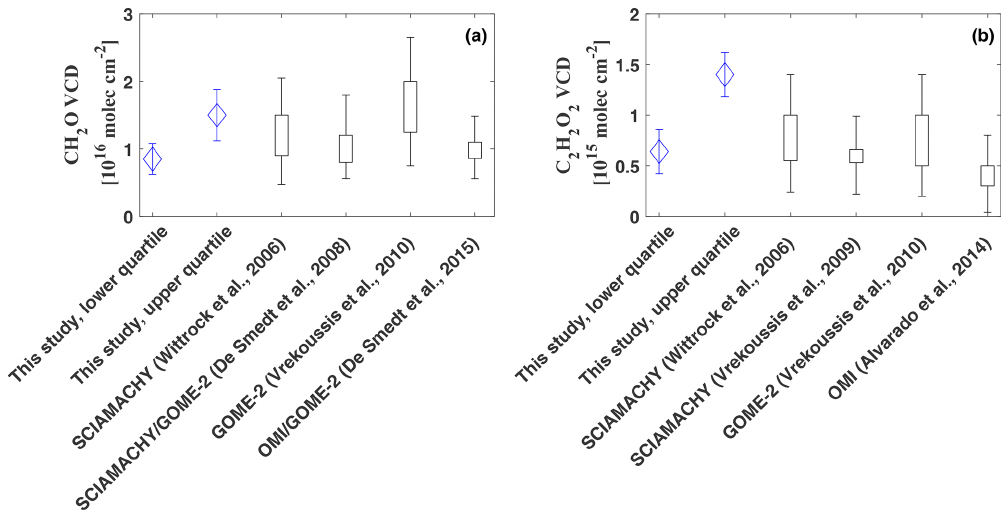
Figure 11. Comparison of the integrated total column densities of CH 2 O (a) and C 2 H 2 O 2 (b) . The vertical bars indicate the range of the observed vertical column amounts as reported in the respective studies. The uncertainty range for Wittrock et al. (2006) and Alvarado et al. (2014) was estimated based on Vrekoussis et al.